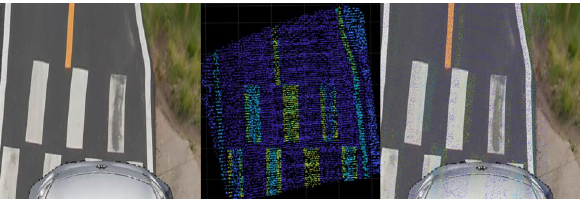
Figure 3. Example of acquired data, image (left)/ point cloud (middle)/ projection of both data (right), (colors represent point